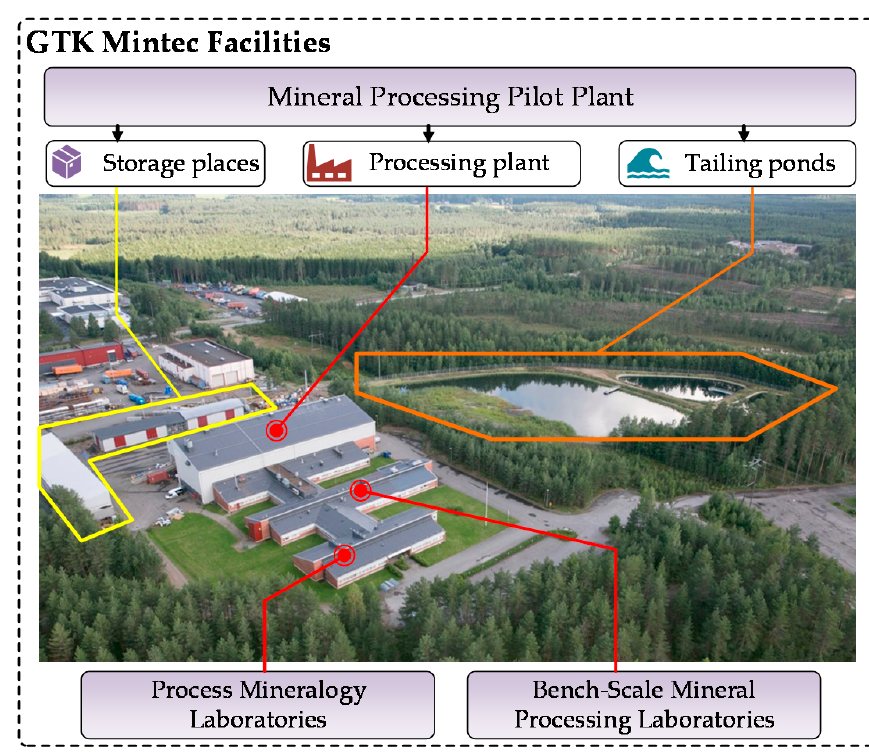
Figure 1. GTK Mintec. The main facilities.